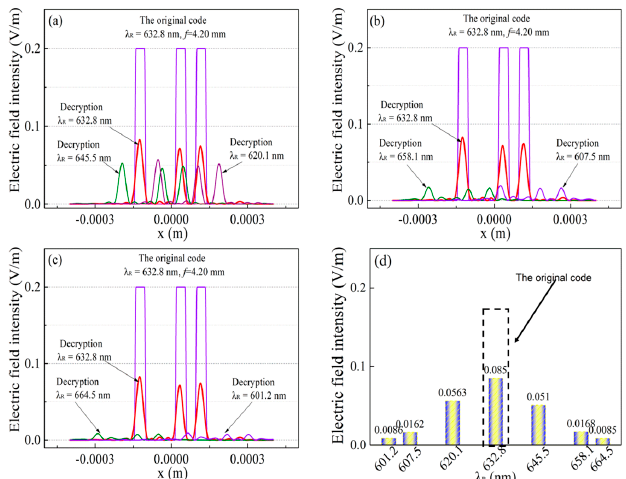
Figure 7. Comparisons between the original code of 632.8 nm and the decrypted code of different reference waves λ R : ( a ) 620.1 nm, 632.8 nm and 645.5 nm, ( b ) 607.5 nm, 632.8 nm and 658.1 nm, and ( c ) 601.2 nm, 632.8 nm and 664.5 nm; ( d ) electric field strength of data decrypted with different reference waves from 601.2 nm to 664.5 nm .